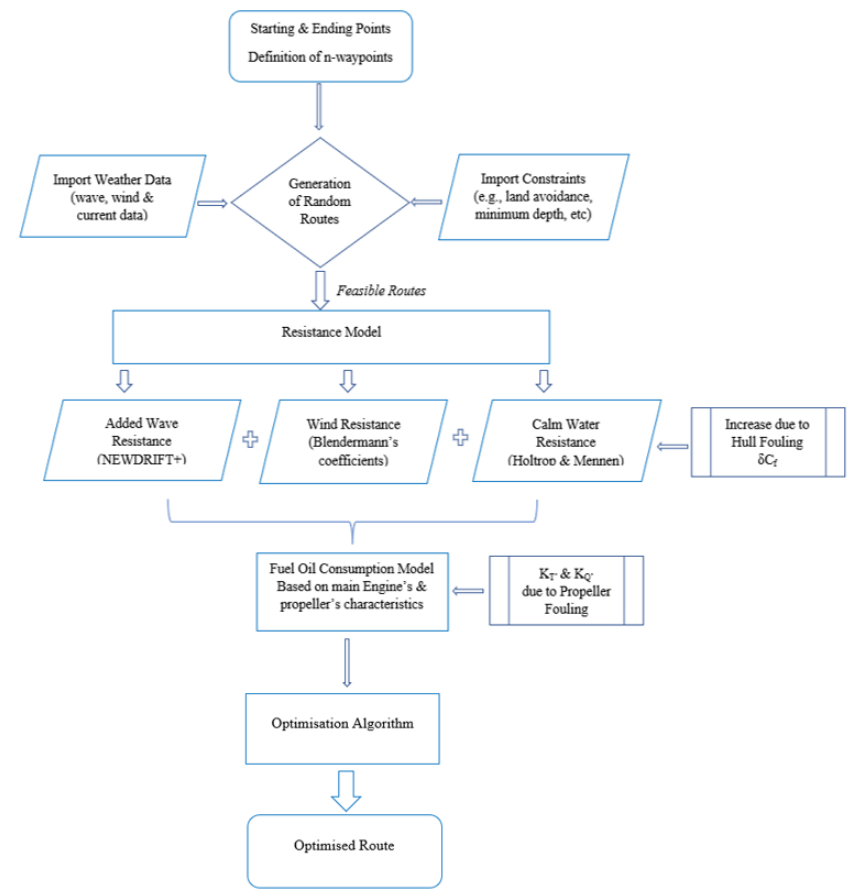
Figure 1. Flowchart of the presented weather routing tool.